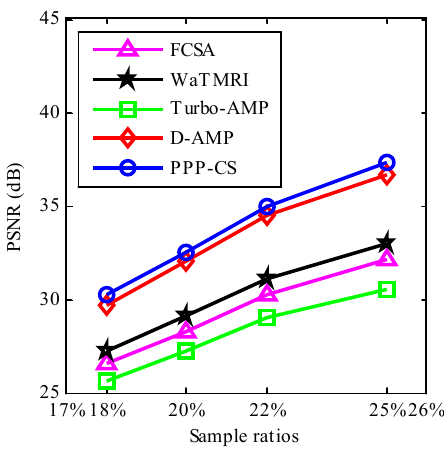
Figure 2. Average PSNR (peak signal to noise ratio) (dB) comparisons on the 12 test images with various sampling ratios.